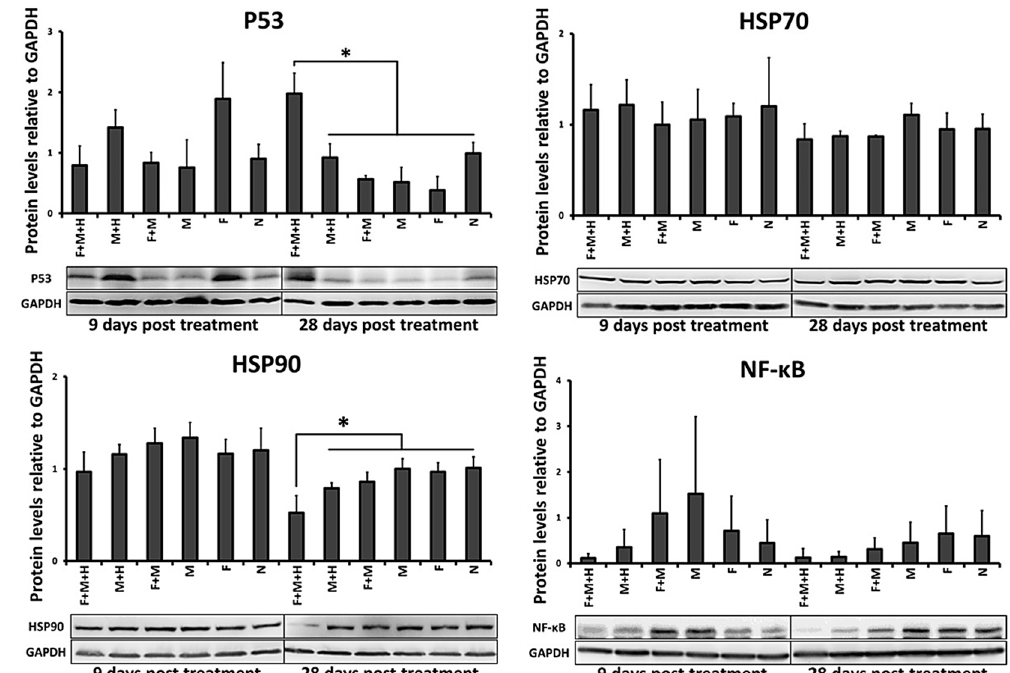
Figure 4. The surviving cells after the thermo-chemotherapeutic tumor treatment experience features of stress. Semi-quantitative analysis of protein expression using 3 independent ex vivo experiments. Representative images of protein bands after Western blot analysis of isolated HT29 xenograft tumor cells at 9 and 28 days after the first magnetic hyperthermia treatment (60 min at H = 15.4 kA/m, f = 410 kHz). GAPDH were used as loading control. F + M + H: combinatorial treatment group (5FU-MNP/MH); M + H: magnetic hyperthermia treatment alone group (MNP/MH); F + M: 5FU-MNP treatment group; M; MNP treatment group; F: 5FU treatment group; N: untreated group; GAPDH, glyceraldehyde 3-phosphate dehydrogenase; NF- κ B: nuclear factor ‘kappa-light-chain-enhancer’ of activated B-cells; HSP: heat shock protein; independent two-sample t-test showed significant differences between the 5FU-MNP/MH and other groups (* p < 0.05).